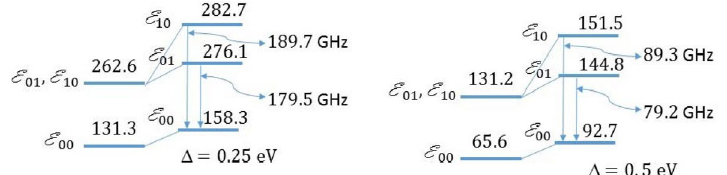
Figure 4. Schematic diagrams for the energy levels and transitions of the direct PME in the strained monolayer graphene. Calculations performed using RK potential for the value of magnetic length l that corresponds to 0.5 eV. The energy levels are given in meV. The diagrams are not B / e 0.25 eV and (cid:31) 50 T and for (cid:31) = = = drawn to